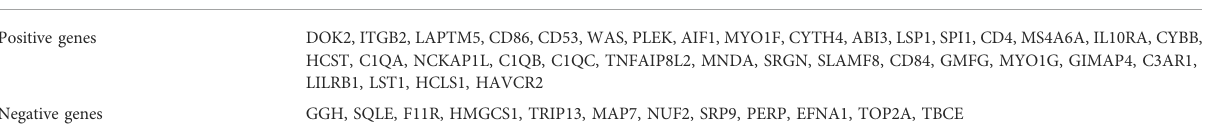
TABLE 1 Marker genes used in IRPM model.